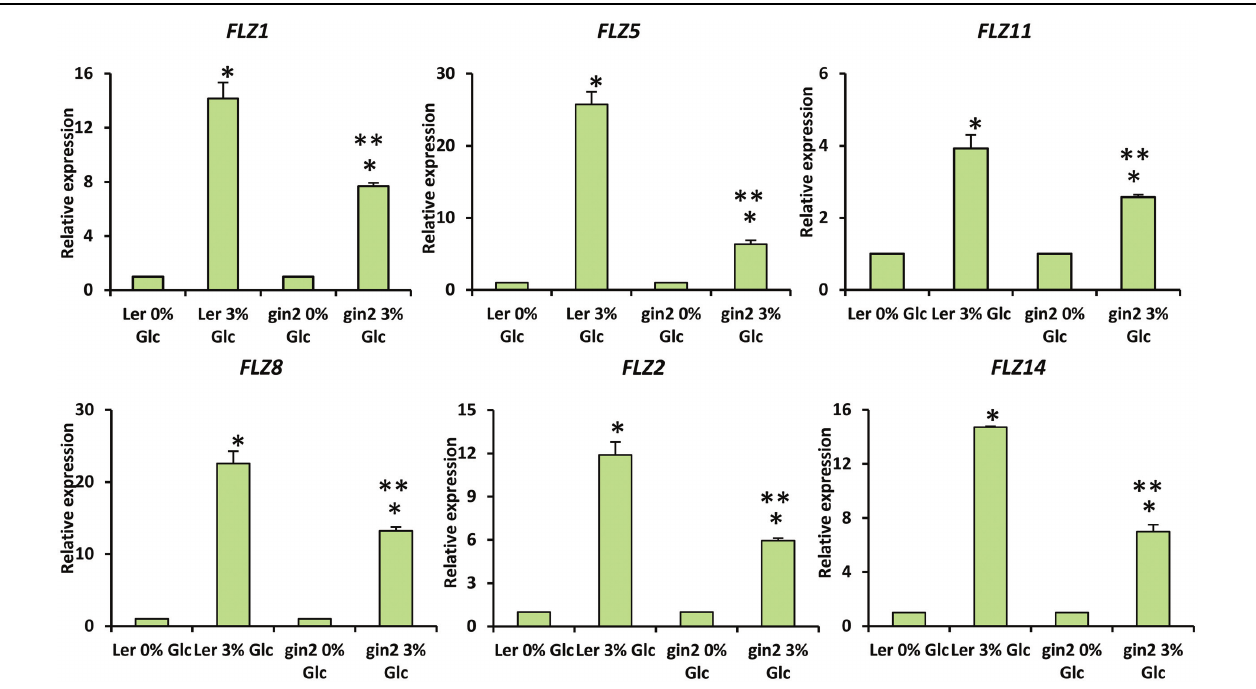
FIGURE 3 | Involvement of HXK1-dependent glucose signaling in the regulation of glucose-dependent up-regulation of FLZ genes. The effect of gin2-1 mutation on the expression of glucose-responsive FLZ genes was studied with qRT-PCR. The expression in 0% sugar treatment in Ler and gin2-1 were taken as the control individually for comparing the expression in 3% glucose treatment in WT and mutant respectively. 18S rRNA was used as endogenous control. The bars represent the average of two independent biological experiments with three technical replicates each and error bars represent SE. Single asterisk indicates a significant difference of expression in the treatment compared to control 0% sugar. Double asterisk indicates a significant difference of expression in the gin2-1 mutant after the treatment compared to the treatment in Ler ( P < 0.005, Student’s t